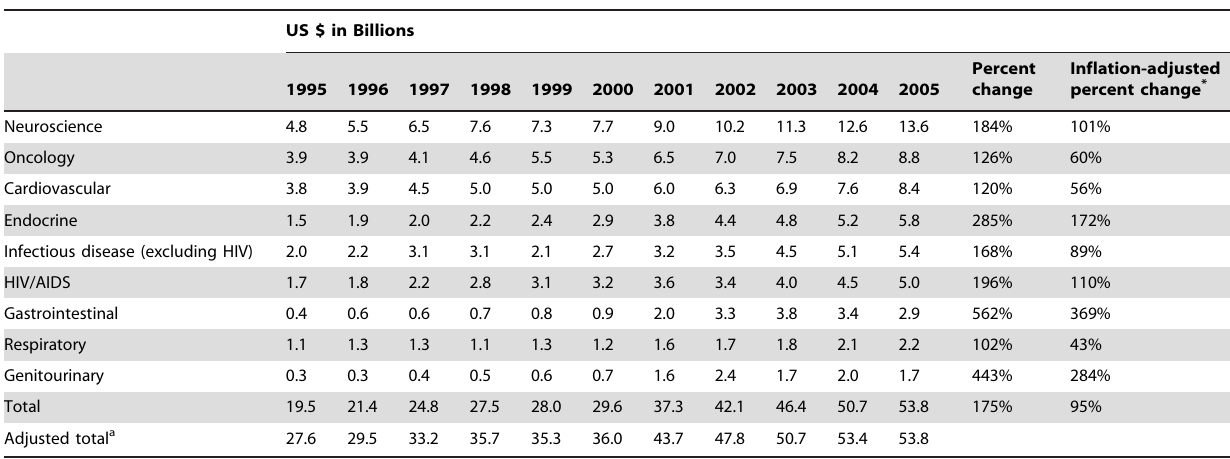
Table 1. Funding for Biomedical Research by Therapeutic Area,